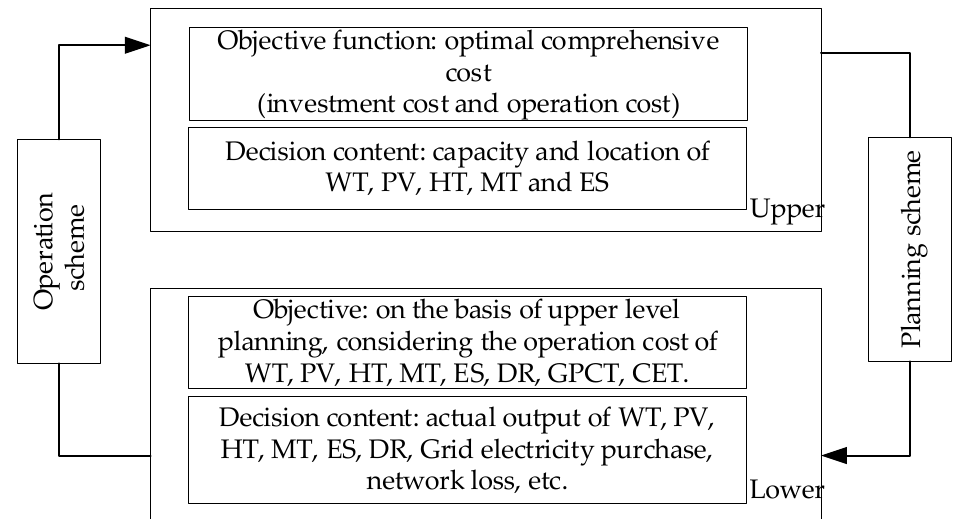
Figure 1. The objective function and decision content of the planning model. The upper layer is a long-time-scale programming model; the lower layer is a short- time-scale simulation operation optimization scheme. The upper layer of the bi-layer model includes integer variables and continuous variables, and the lower layer is a mixed-integer nonlinear programming (MINLP) problem. There is a coupling relationship between the upper and lower models, which is difficult to directly solve. Since the lower layer belongs to convex optimization, the KKT condition is a sufficient and necessary condition for the optimality of the solution of the convex optimization problem. In this paper, the single-layer transformation method is used to construct the Lagrangian function of the lower-layer model. Based on the KKT condition of the lower-layer model, the lower-layer model is converted to the constraints of the upper model, while the bi-layer model is transformed into a single-layer, nonlinear programming model. Then, the Big-M method is used to linearize the nonlinear part of the transformed, single-layer, nonlinear model to form a single-layer MISOCP problem [31]. For details on the transformation process, please refer to the Appendix A. In Matlab2016b, the YALMIP toolbox and the CPLEX12.7 solver are used to solve the problem. The specific process is shown in Figure